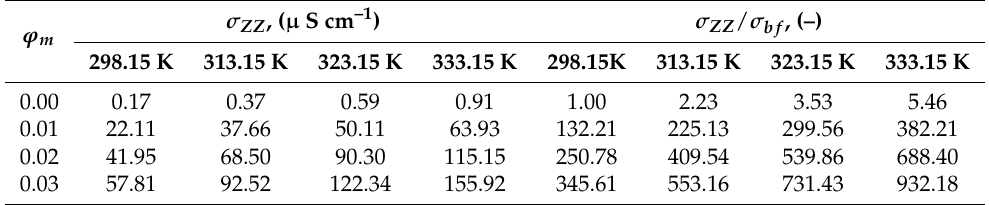
Table 2. Values of DC electrical conductivity, σ ZZ , of silicon oxide lignin ethylene glycol nanofluids and their enhancement for various temperatures and mass fractions calculated based on Nyquist plots (Figure 9) and Equation